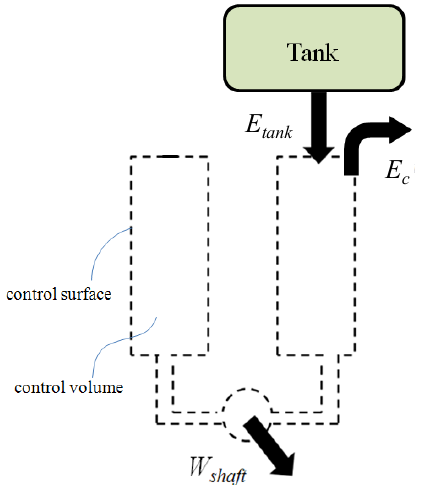
Figure 14. The energy balance of the